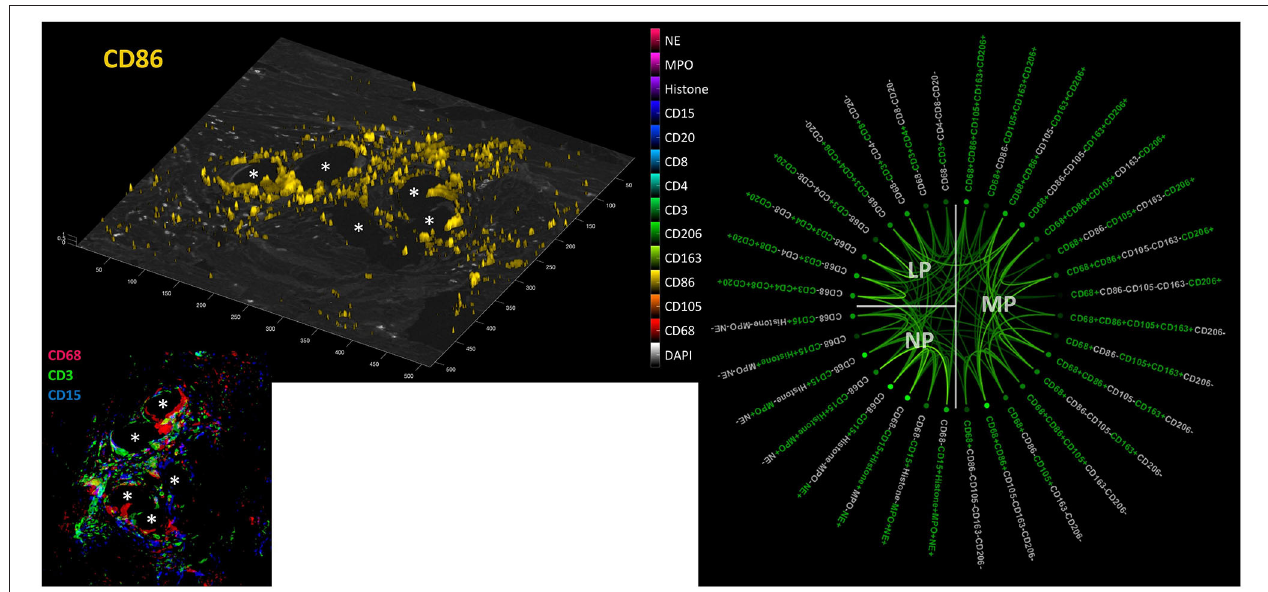
FIGURE 9 | Collaboration network in the FBG. Left : Example image from a video file (available as Supplementary Material ) showing all “positive” cells (threshold = mean + 2 SD) for all 13 markers on a DAPI image; CD86 is shown here. Inset : CD68 + macrophages (red), CD3 + lymphocytes (green), and CD15 + neutrophils (blue) in the FBG of a PP mesh. Asterisks mark fiber locations. Right : Significant Pearson’s correlations ( p < 0.05) within and between macrophage (MP), lymphocyte (LP), and neutrophile (NP) panels. Marker colored green = positive and marker colored light gray = negative. The stronger the saturation of the depicted correlations between individual marker combinations, the higher is their correlation